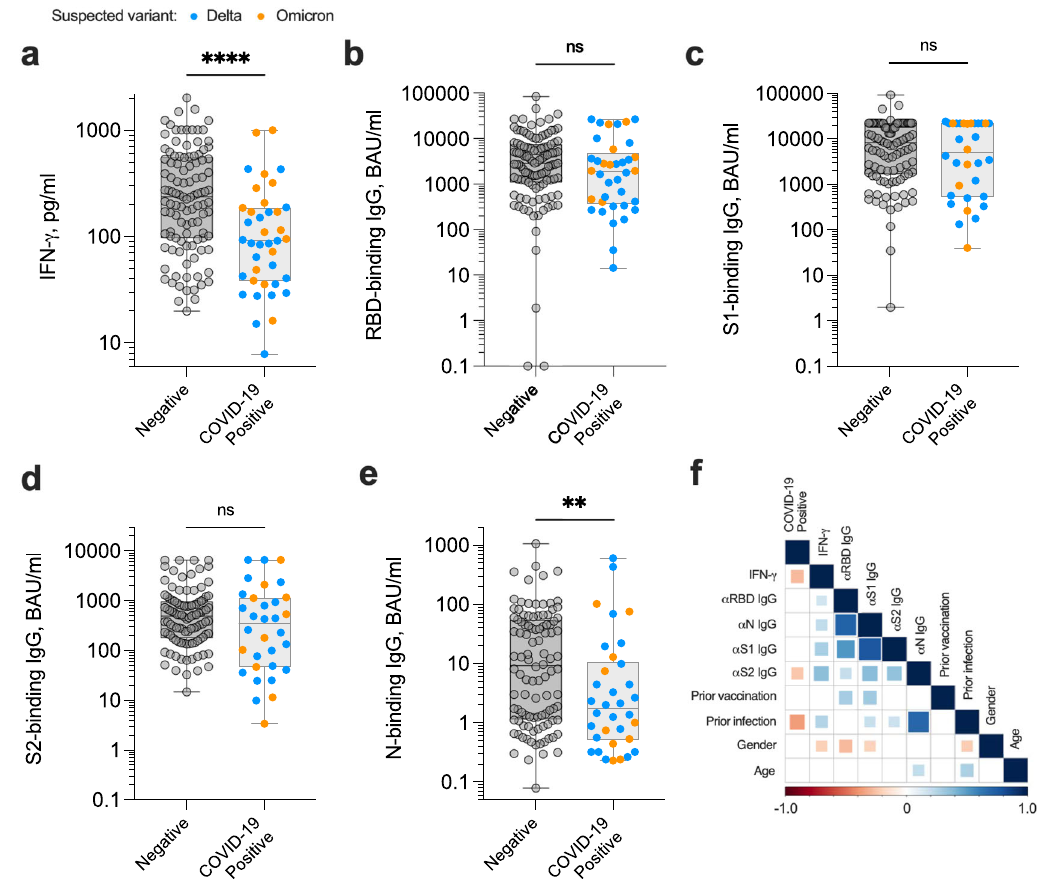
Fig.2|Magnitudeofanti-SARS-CoV-2adaptiveimmuneresponsesmeasuredin venous blood samples up to six months preceding a positive COVID-19 test. Venous blood samples obtained from healthy donors ( n =148) were assessed for themagnitudeofSARS-CoV-2-speci fi cIFN- γ + Tcellresponses( a ;**** P <0.0001)and SARS-CoV-2-speci fi c IgG-binding responses targeting spike receptor binding domain ( ‘ RBD ’ ) ( b ), spike subunit 1 ( ‘ S1 ’ ) ( c ), spike subunit 2 ( ‘ S2 ’ ) ( d ) and nucleo- capsid ( ‘ N ’ ) ( e ; ** P =0.0084). Participants self-reporting a COVID-19 positive test